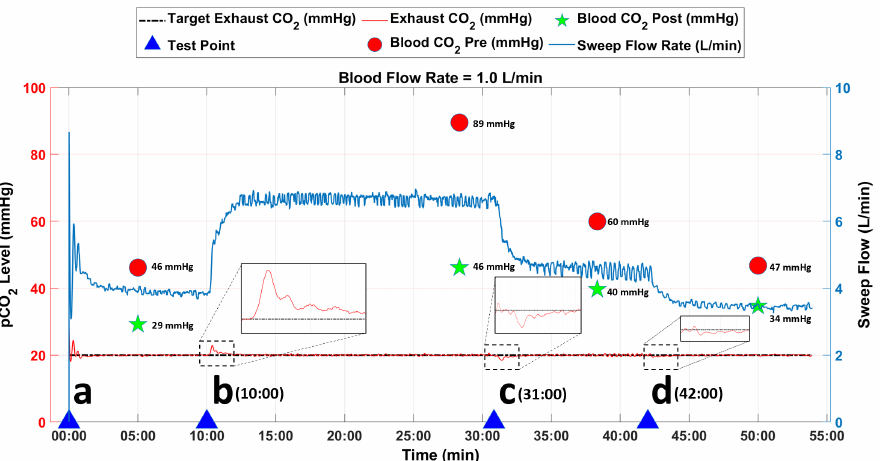
Figure 6. Data from in vitro study at AL blood flow rate of 1.0 L/min. The blue arrows represent the time points when the inlet blood pCO 2 levels were changed to challenge the tuning of the PID